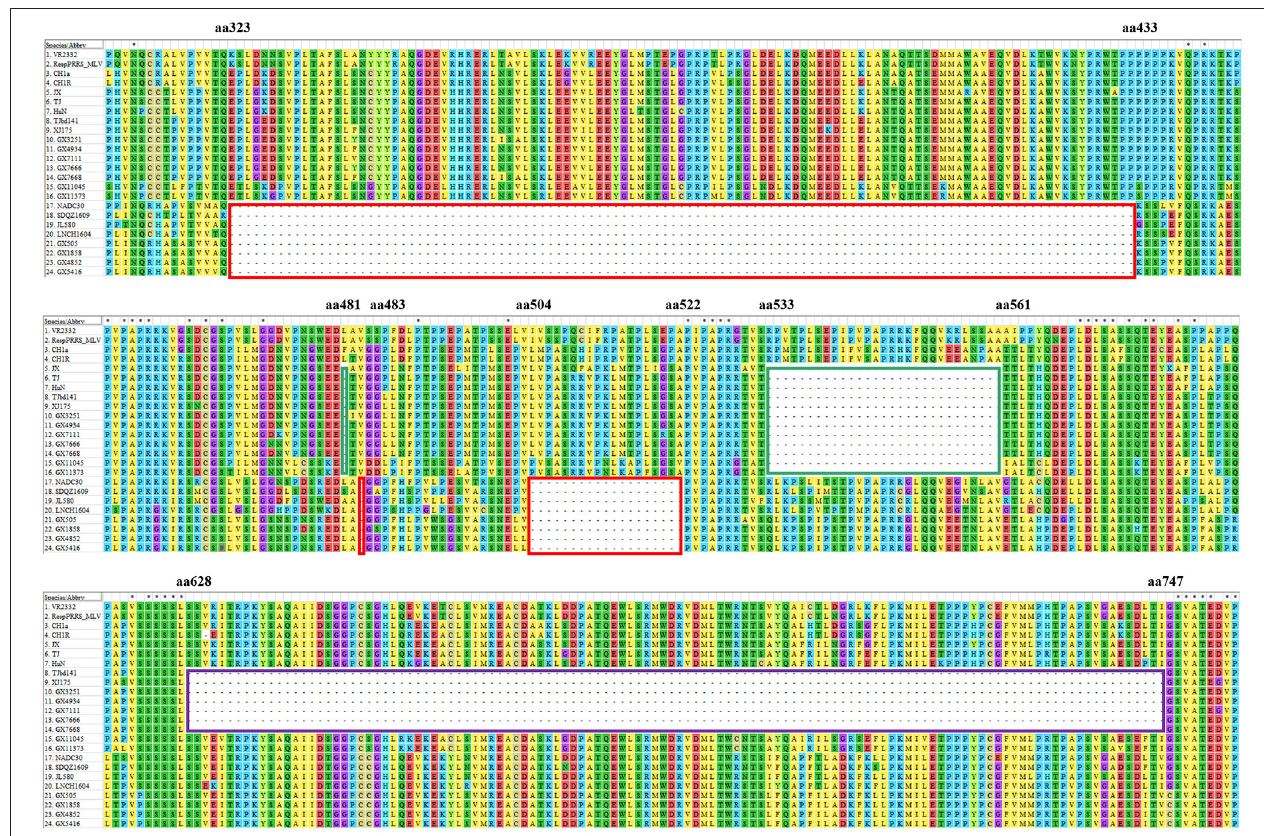
FIGURE 4 | Alignment of the Nsp2 amino acid sequences of the eleven PRRSV isolates. The 131-amino-acid discontinuous deletion of NADC30-like PRRSVs is shown in red box. The 30-amino-acid discontinuous deletion of highly-pathogenic PRRSVs is shown in green box. The additional 120 amino-acid deletion of MLV-derived PRRSVs is shown in purple